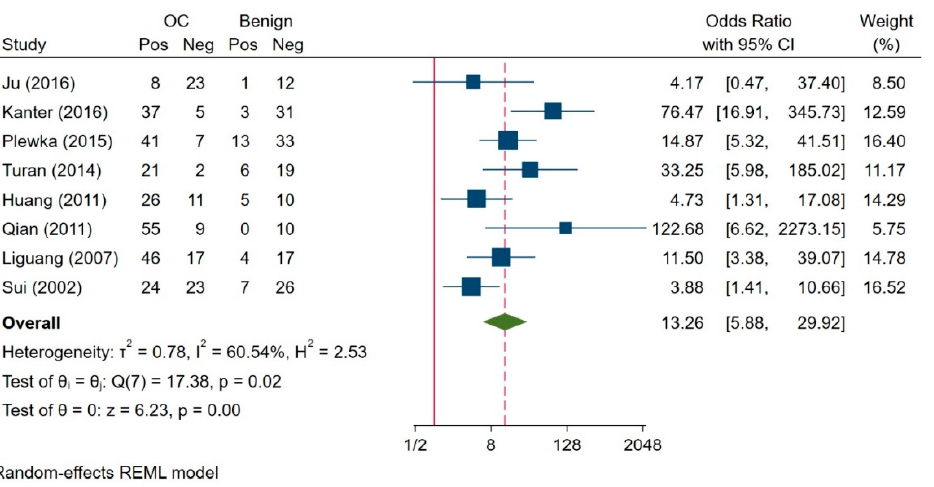
Figure 3. Comparison of survivin expression between ovarian carcinoma and benign tumour [3,7,31–33,36,38]. Abbreviations: OC =Ovarian Cancer; REML = The Restricted Maximum Likeli- hood.